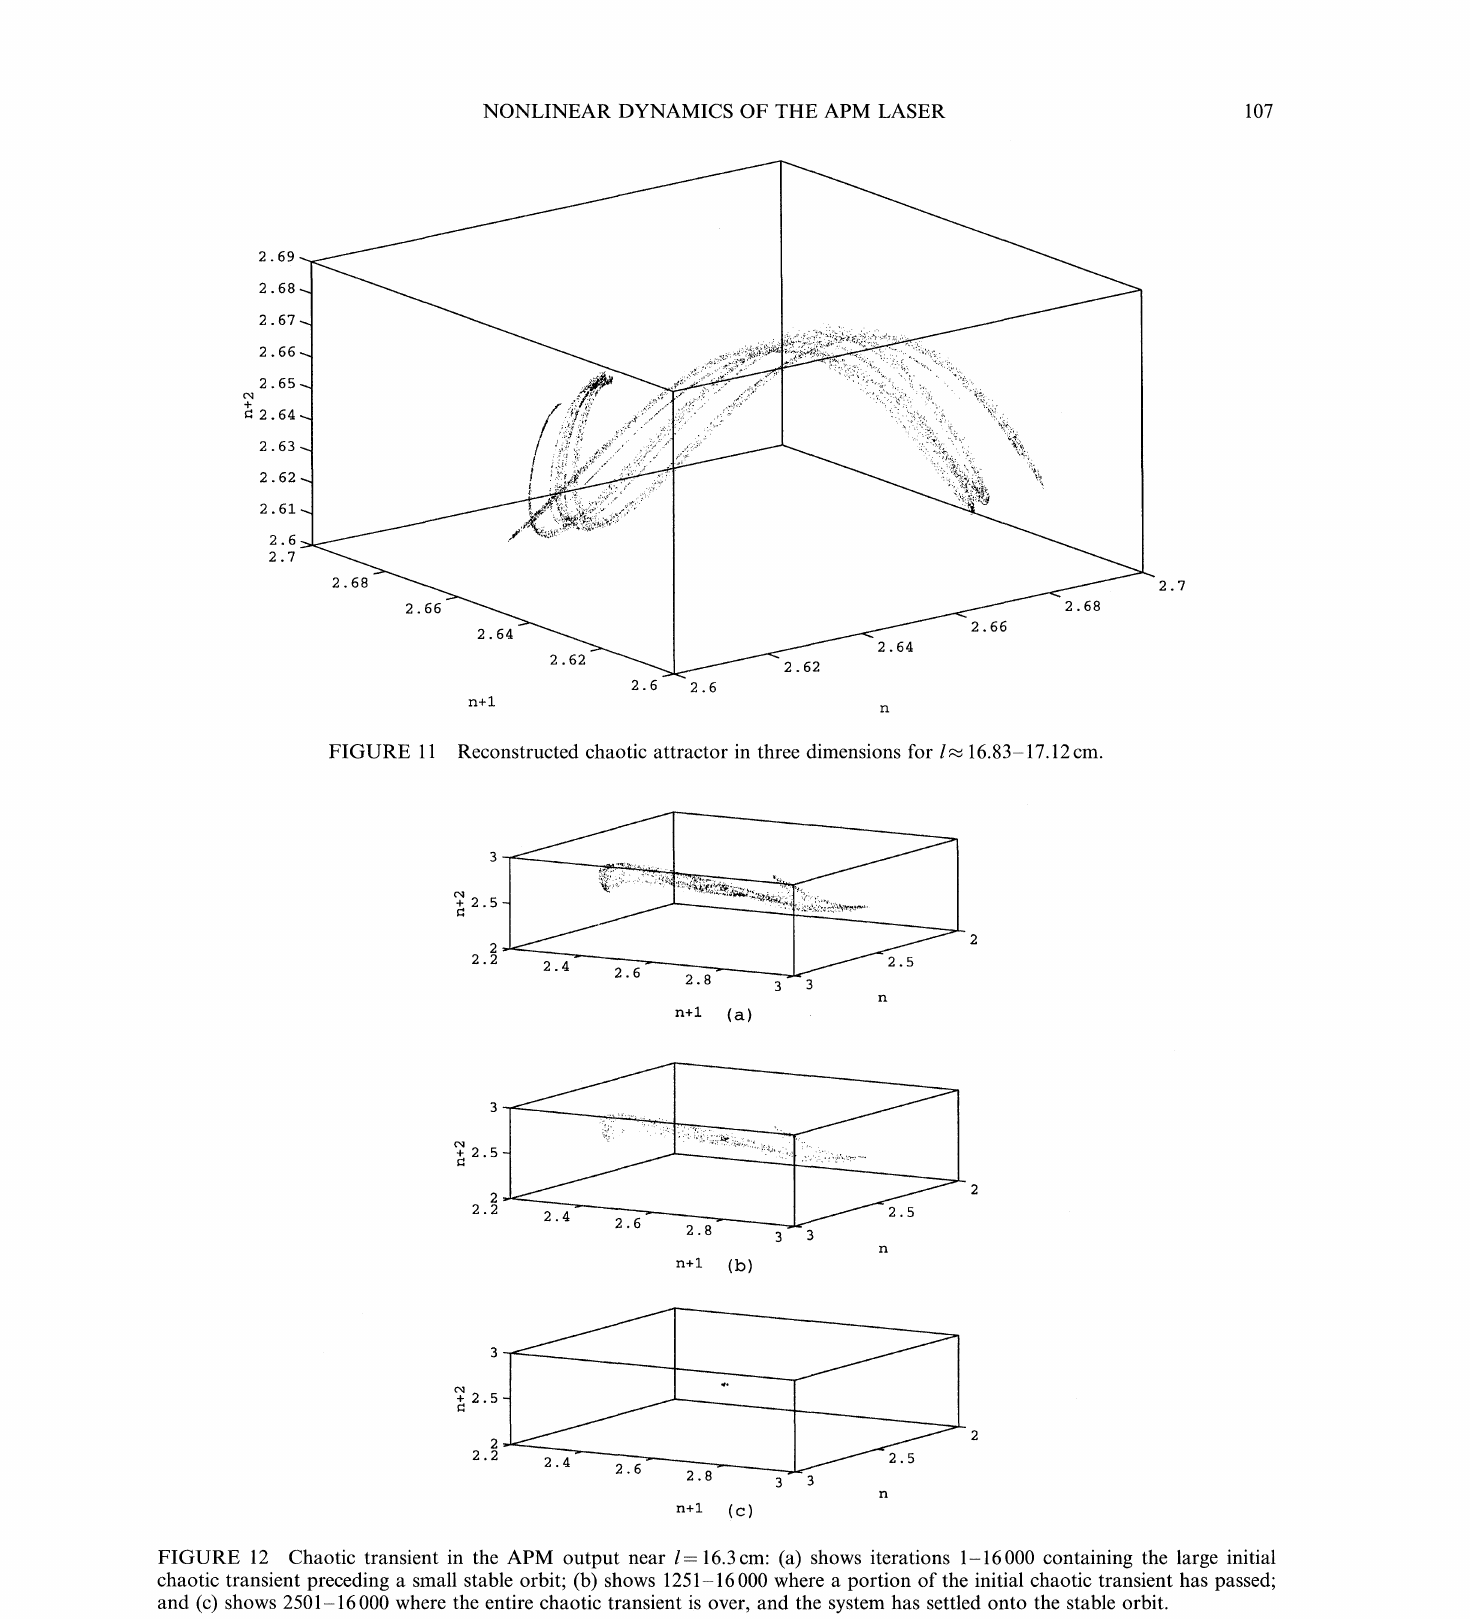
FIGURE 12 Chaotic transient in the APM output near l= 16.3cm: (a) shows iterations 1-16000 containing the large initial chaotic transient preceding a small stable orbit; (b) shows 1251-16000 where a portion of the initial chaotic transient has passed; and (c) shows 2501-16 000 where the entire chaotic transient is over, and the system has settled onto the stable